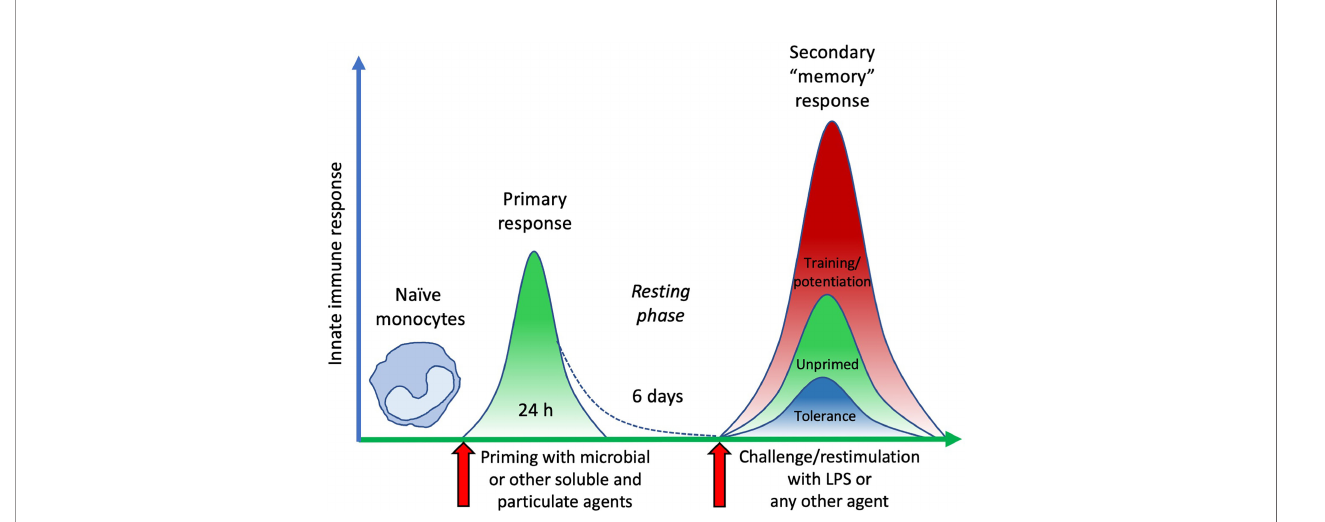
FIGURE 3 | The time course of an in vitro model of innate immune memory. Fresh naïve monocytes are activated by exposure in culture to different stimuli for 24 h (primary response). After elimination of stimuli, cell activation subsides with time (in our in vitro model 6 days are suf fi cient), during which period cells return to a resting status. Upon restimulation, cells that were not previously exposed to activating agents (unprimed) develop a secondary response of a given intensity. Conversely, cells that were previously primed and activated can react to restimulation with a secondary “ memory ” response, either more powerful (training/ potentiation) or reduced (tolerance), compared to unprimed